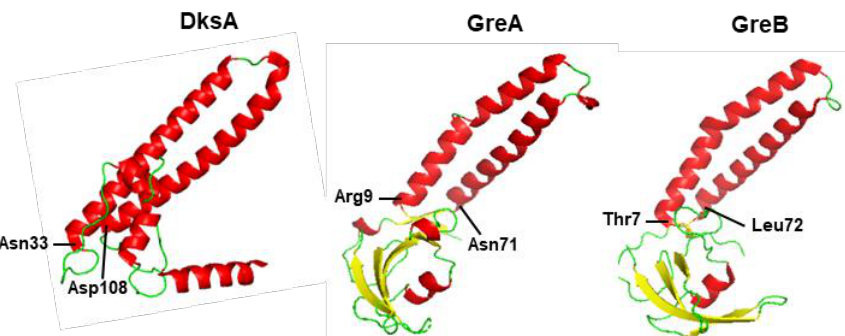
Figure 2. Structure similarity between DksA and GreA/B proteins. The coil-loop-coil domain of the proteins are shown, using the PyMol software [88]. The structures, fetched from the open-access RCSB PDB (Research Collaboratory for Structural Bioinformatics Protein Data Bank) at www.rcsb.org, are: 1TJL (DksA), 1GRJ (GreA), and 2P4V (GreB). The amino acid residues at the beginning and end of the domains are labeled; the helices are colored Red, whereas the loop regions and beta-strands are Green and Yellow, respectively.